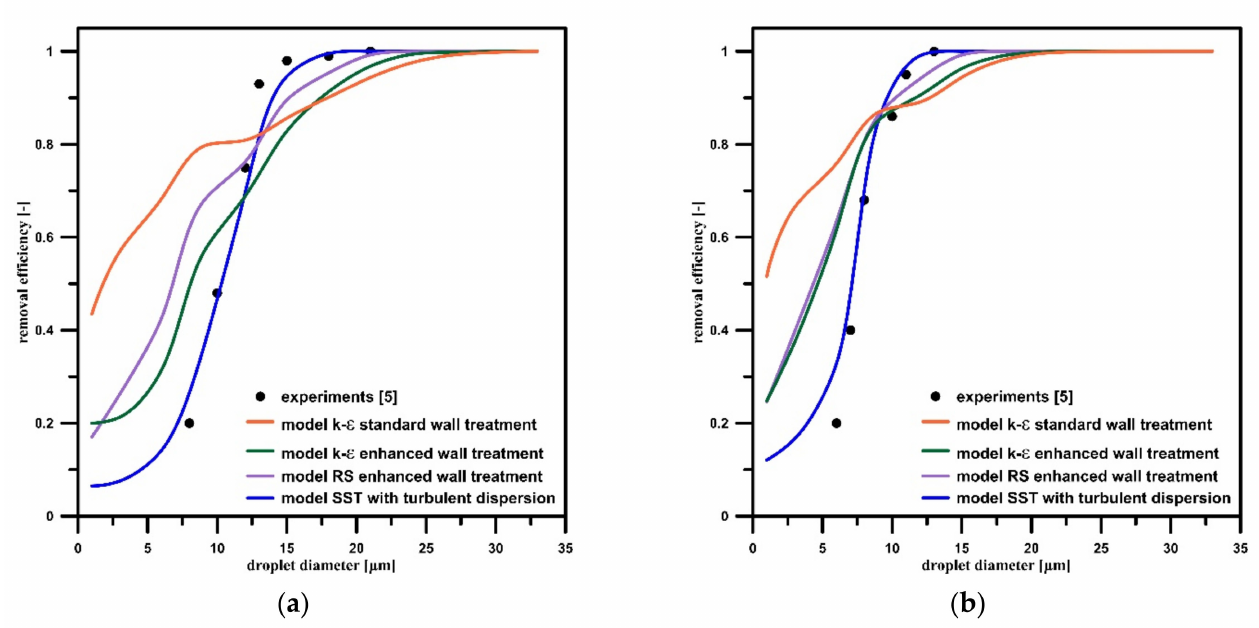
Figure 5. Comparison of calculated results with experimental data for geometry B_10_0 with inlet velocity: ( a ) 2 m s − 1 ; ( b ) 4 m s − 1 . Table 2. Comparison of calculated results with experimental data for geometry B_10_0 with inlet velocity 2 m s − 1 . Droplet Diameter